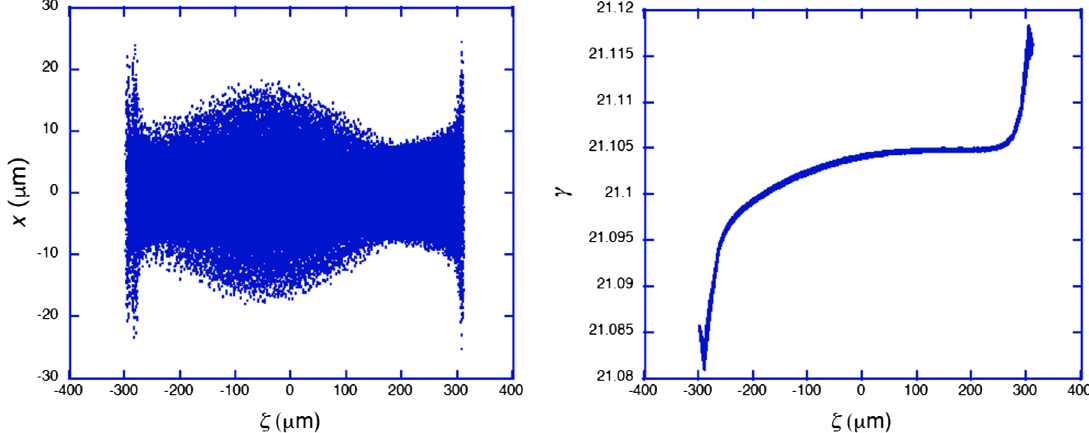
FIG. 6. (left) Spatial beam distribution at emittance compensation minimum, in low-charge cigar-beam case, at z ¼ 2 . 2 m, where the uniform distribution launched at photocathode is nearly recreated near the emittance compensation waist. (right) Longitudinal emittance for this